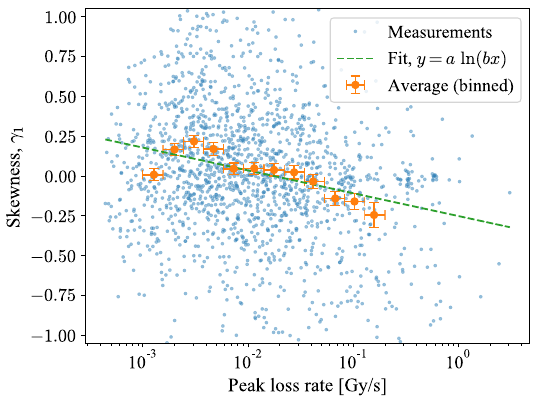
FIG. 3. Measured skewness and peak loss rate of 1719 UFO events observed during Run II. The fit parameters are a ¼ − 0 . 062 (cid:2) 0 . 007 and b ¼ 56 (cid:2) 11 . Only events with sufficient signal which occurred for colliding beams at top energy are shown. The orange dots indicate the average skewness and average peak signal of the data within the bins defined by the horizontal bars and standard error of the mean shown by vertical